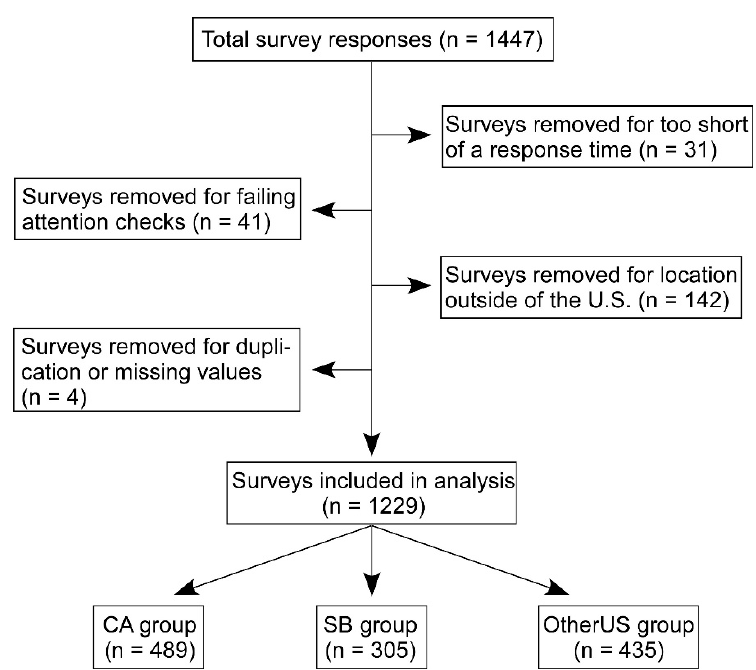
Figure 1. Survey responses were collected through Amazon Mechanical Turk. A total of 1443 responses were collected, and 31 were removed for completing the survey in less than 90 s, 41 were removed for failing to pass attention check questions located within the survey, and 142 surveys were rejected for not being located within the US. A total of 1229 surveys were used for analysis, with 489 from California (CA), 305 from the Stroke Belt (SB), and 435 from other locations within the United States (OtherUS).